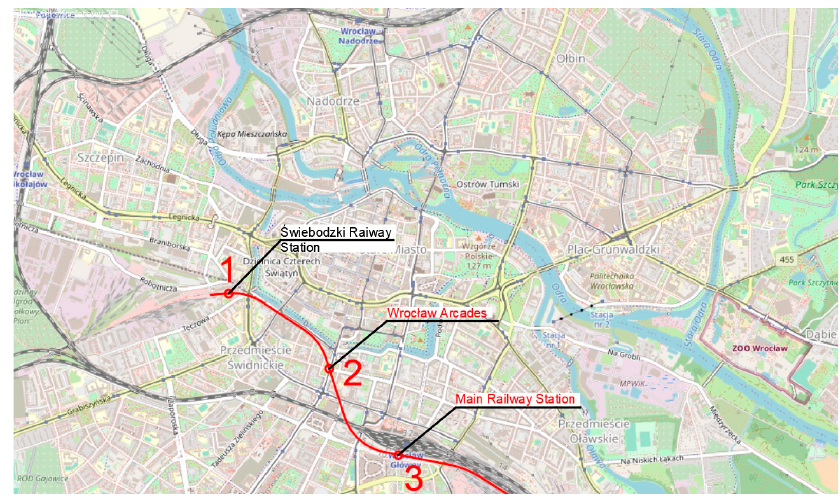
Figure 7. Route three (background: openstreetmap.org).